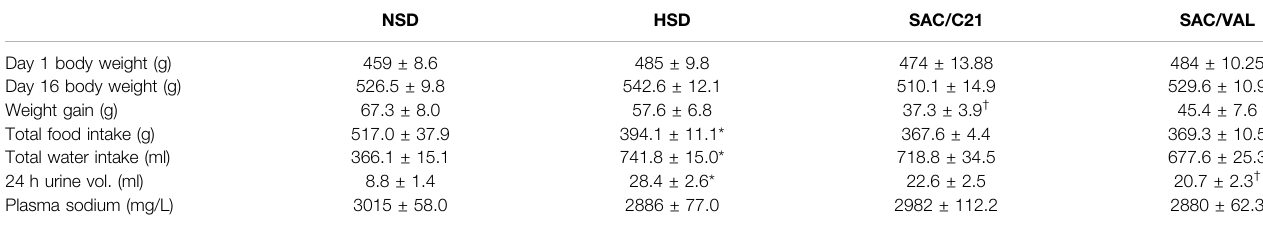
TABLE 1 | General parameters.